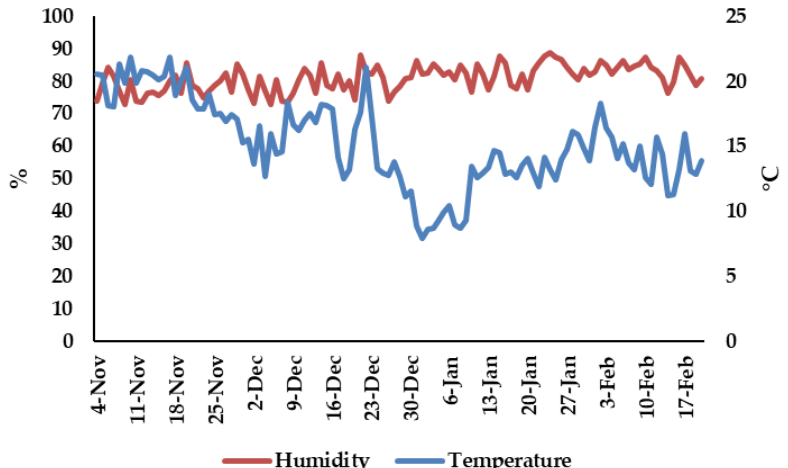
Cluj-Napoca, Romania). Recorded average humidity during the experiment was 80.9%, and the average temperature was 15.19 °C (Figure 8).